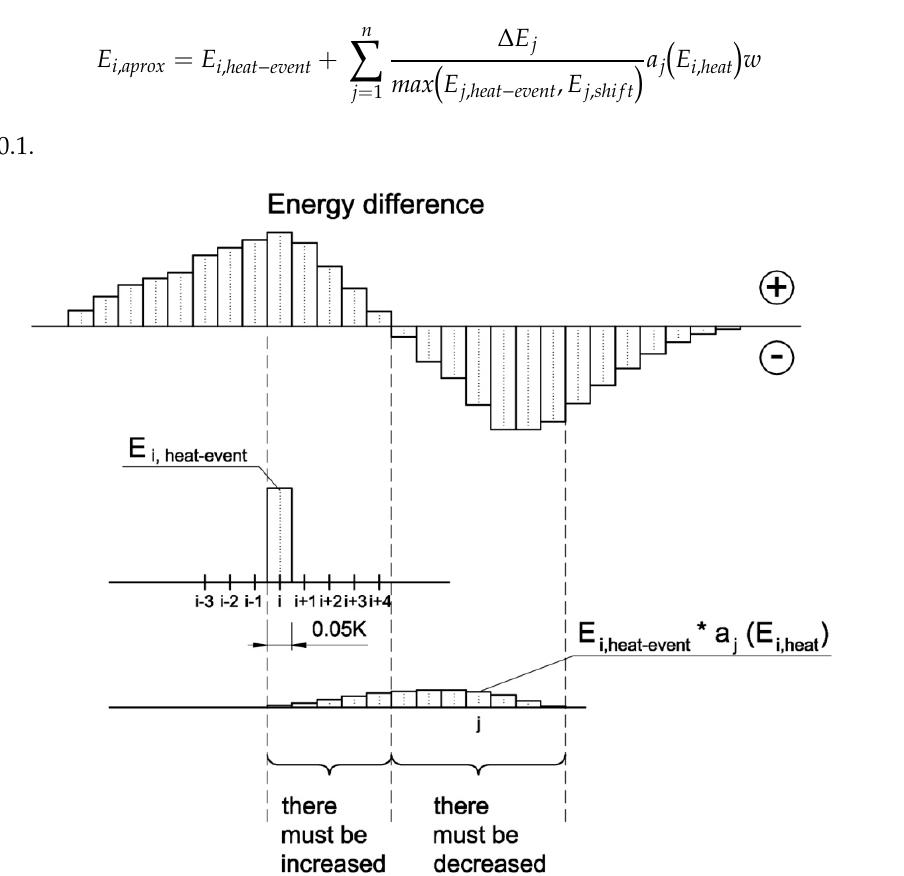
Figure 11. Schematic of heat pulse segments to be increased or decreased depending on the energy differences data.